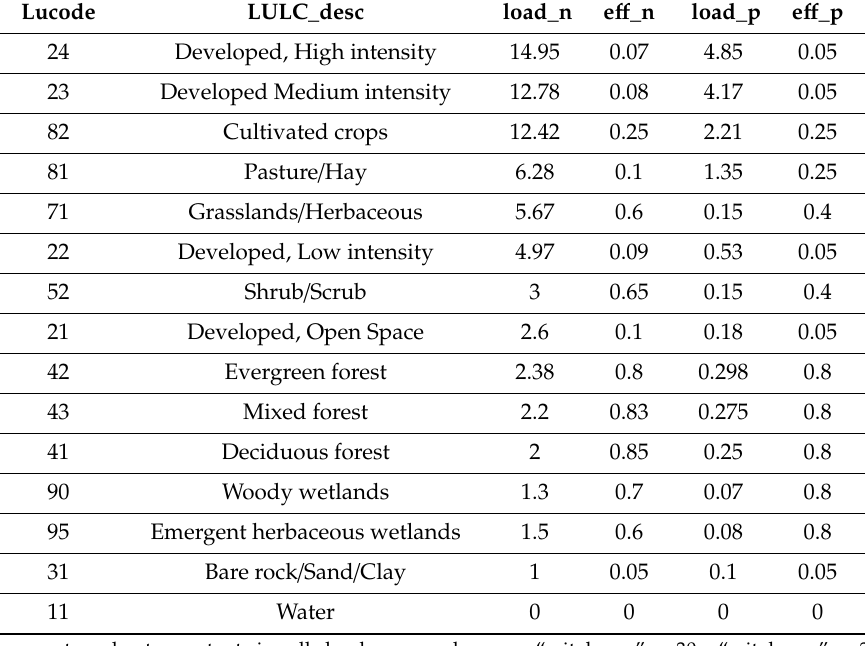
Table A1. Biophysical table used for scenarios using the NLCD land cover